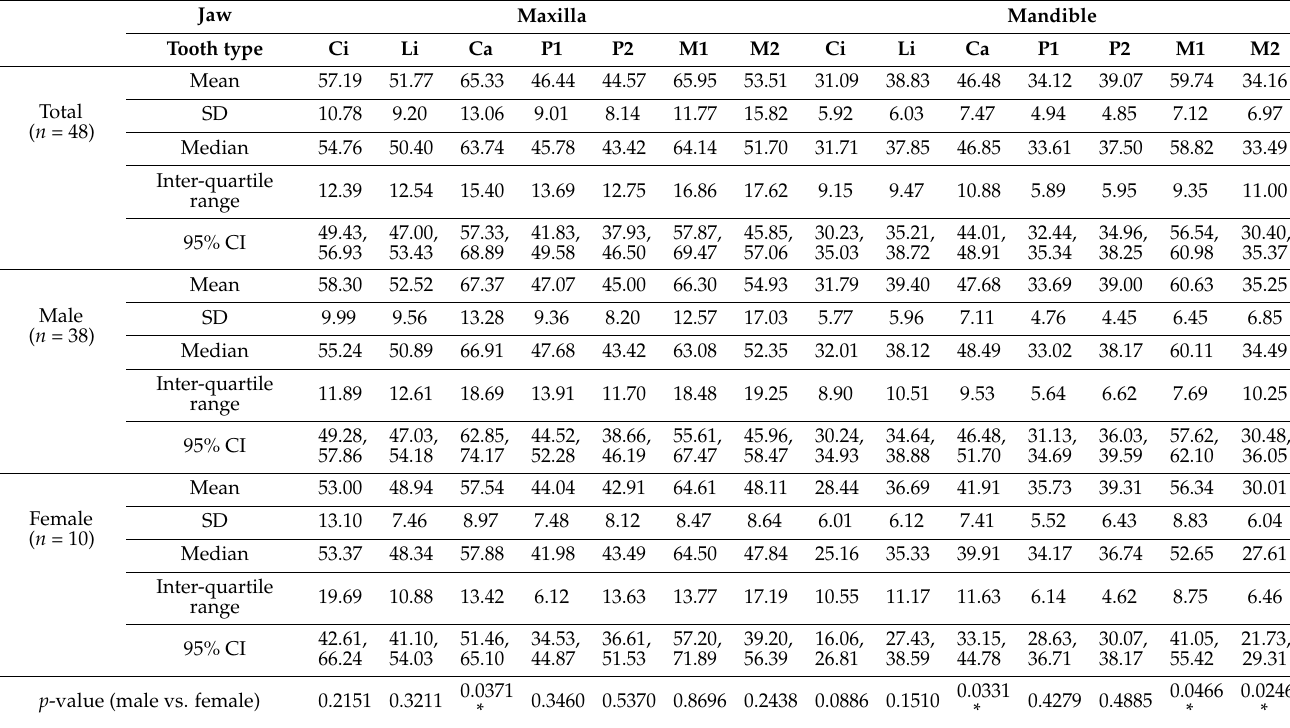
Table 3. Area of the keratinized gingiva (in mm 2